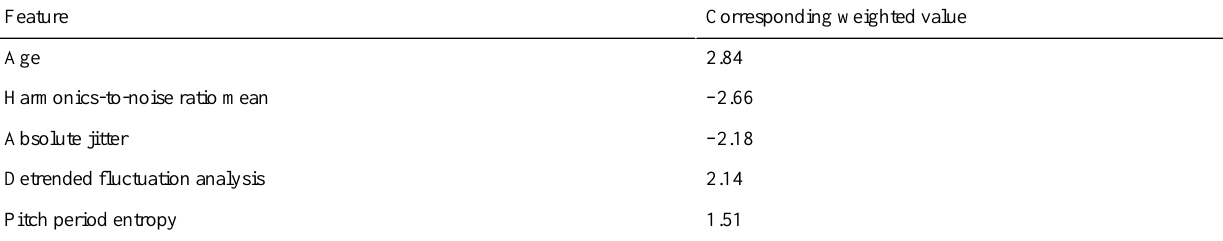
Table 8. Top five principal